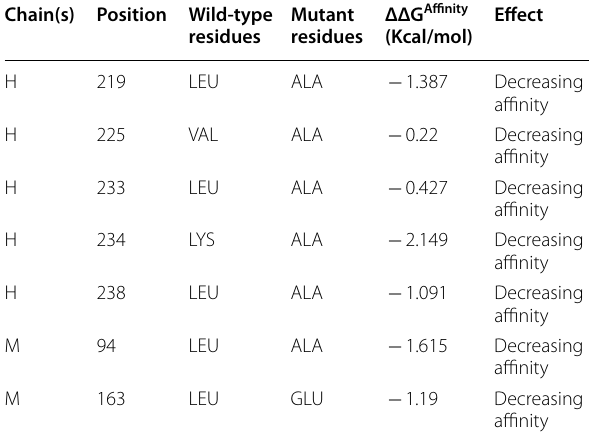
Table 3 mCSM-PPI2 binding affinity change prediction upon residue mutation